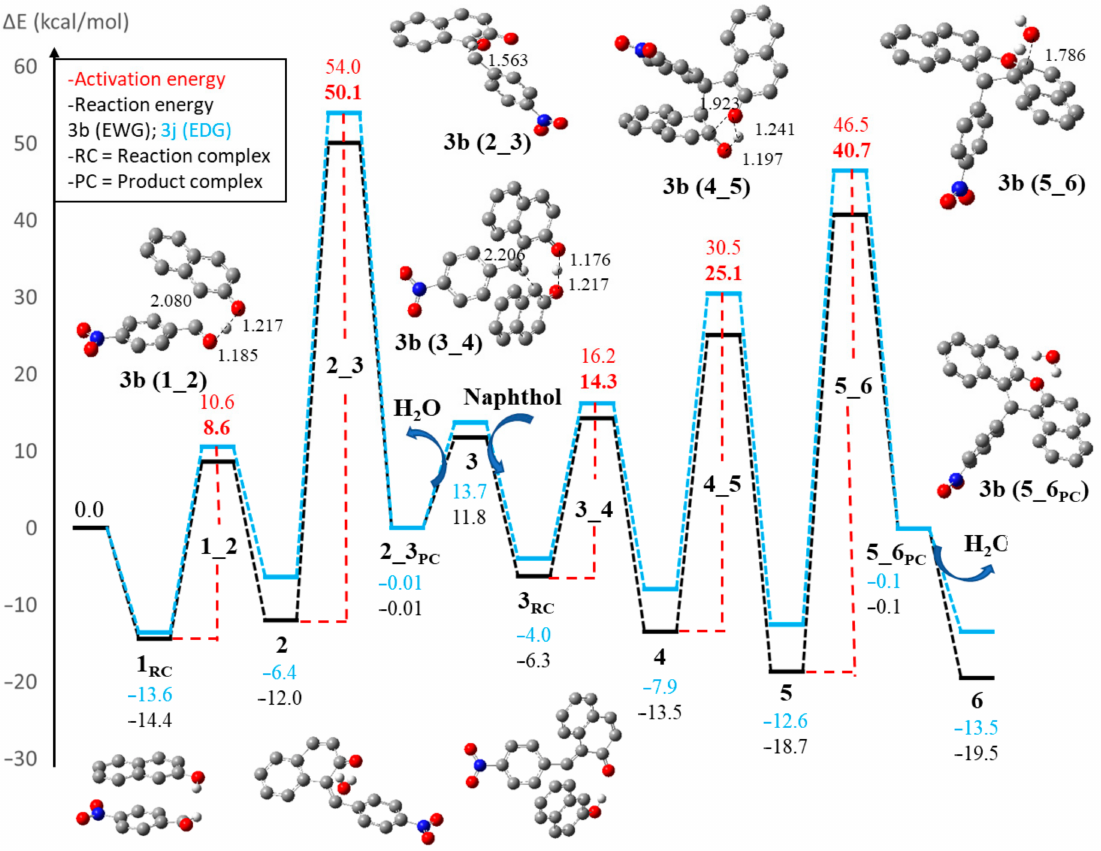
Figure 5. Reaction energy profile for the xanthene derivative formation using the M06-2X/6-31G(d,p) level of theory. The activation energy (red) for 3b is shown in bold and for 3e in